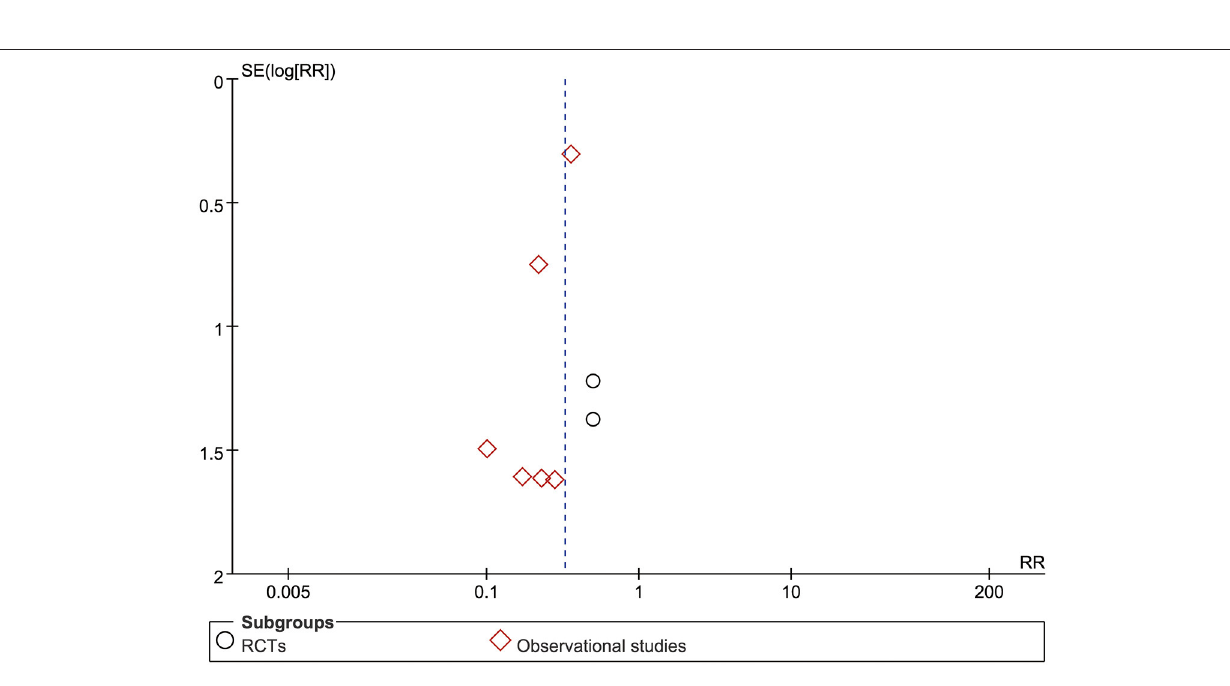
FIGURE 5 | Funnel